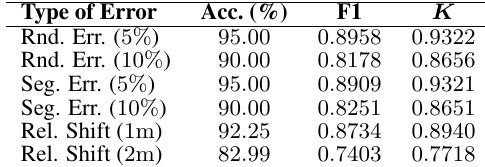
Figure 2. Label inference on the objects of the unseen test tile 6 10 . (a) Ground truth, (b) Inference by the base line model, (c) Inference by the model trained on 5% segment errors, (d) Table 1. Evaluation of simulated label errors in the combined Inference by the model trained on 1m relative training data (training set from Potsdam dataset + training set from Vaihingen dataset). The corresponding accuracy, Cohen’s Kappa ( K ) coefficients and F1 scores are shown in the respective columns.